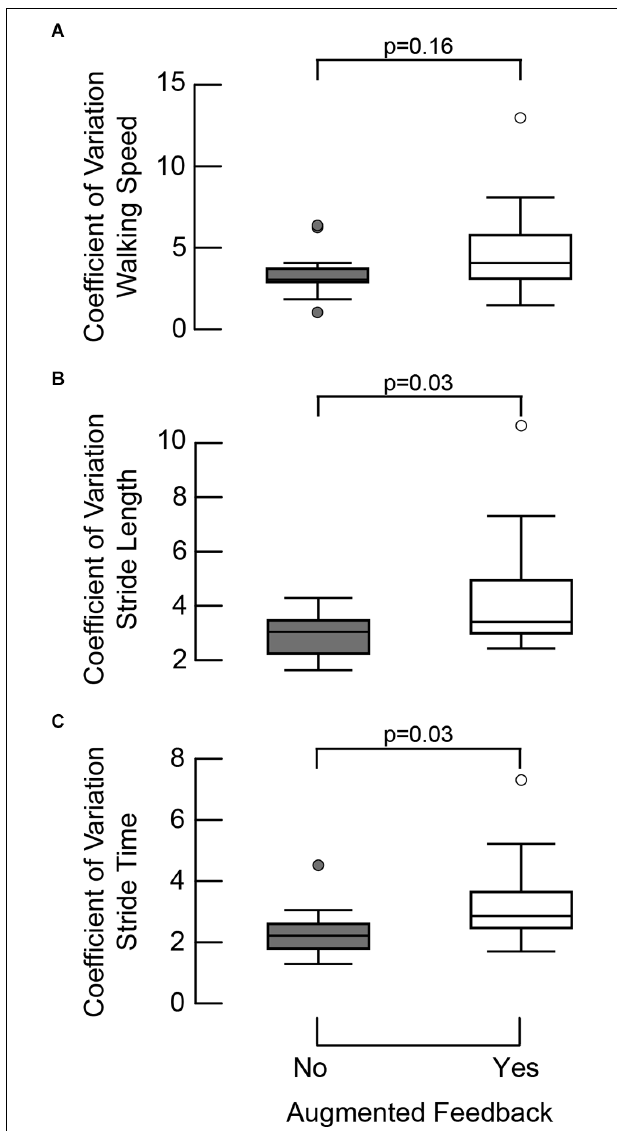
FIGURE 4 | Coefficient of variation in walking speed, stride length, and stride time with and without augmented feedback. (A) Comparison of the baseline SS with SS 100 condition showed that variability of walking speed did not differ when walking overground with and without MR-HMD feedback (CoV difference: 1.44, CI95: − 0.54, 3.42, p = 0.16). (B) There was more variability in stride length (CoV difference: 1.47, CI95: 0.16, 2.78, p = 0.03) and (C) stride time (CoV difference: 1.00, CI95: 0.10, 1.88, p = 0.03) with MR-HMD feedback suggesting that individuals adopted more variable control strategies to achieve the target